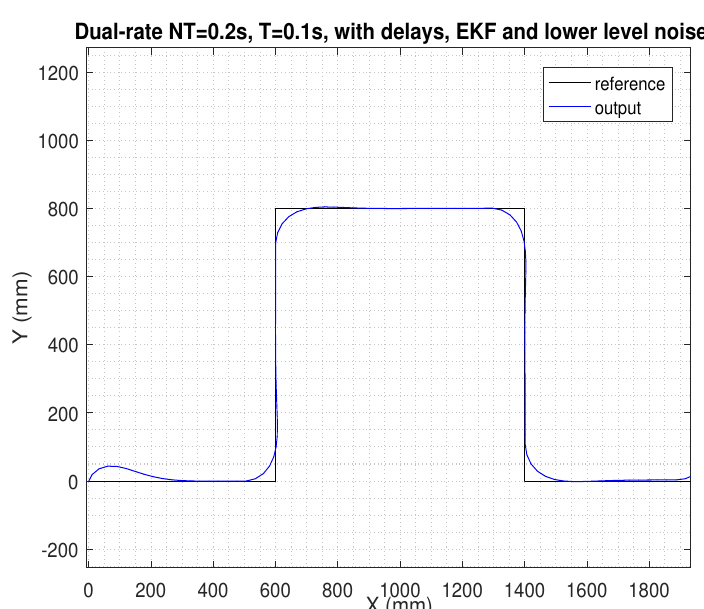
Figure 9. Results for the control proposal (EKF, prediction stage, and packet-based control) with delays and a lower level of